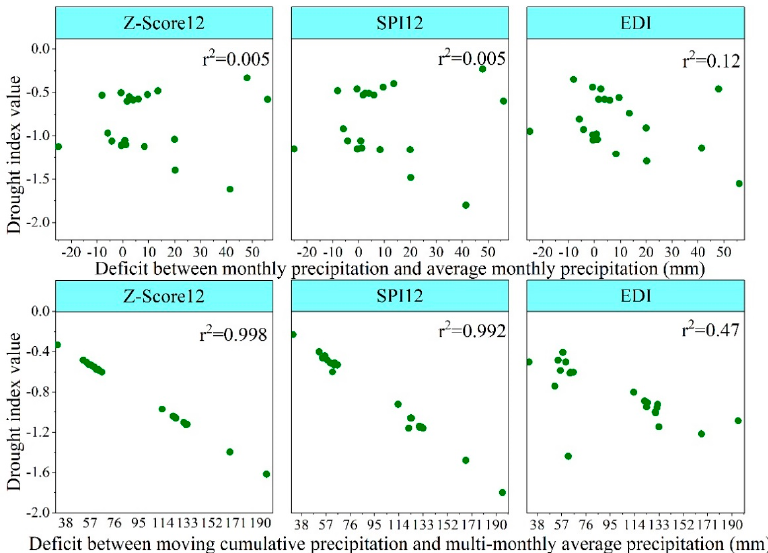
Figure 8. Scatter plots of drought indices (i.e., Z-Score12, SPI12, and EDI) and deficit between monthly precipitation and average monthly precipitation (the first row) and deficit between moving cumulative precipitation and multi-monthly average precipitation (the second row) for 12-month timestep in Keshan station from September 1999 to May